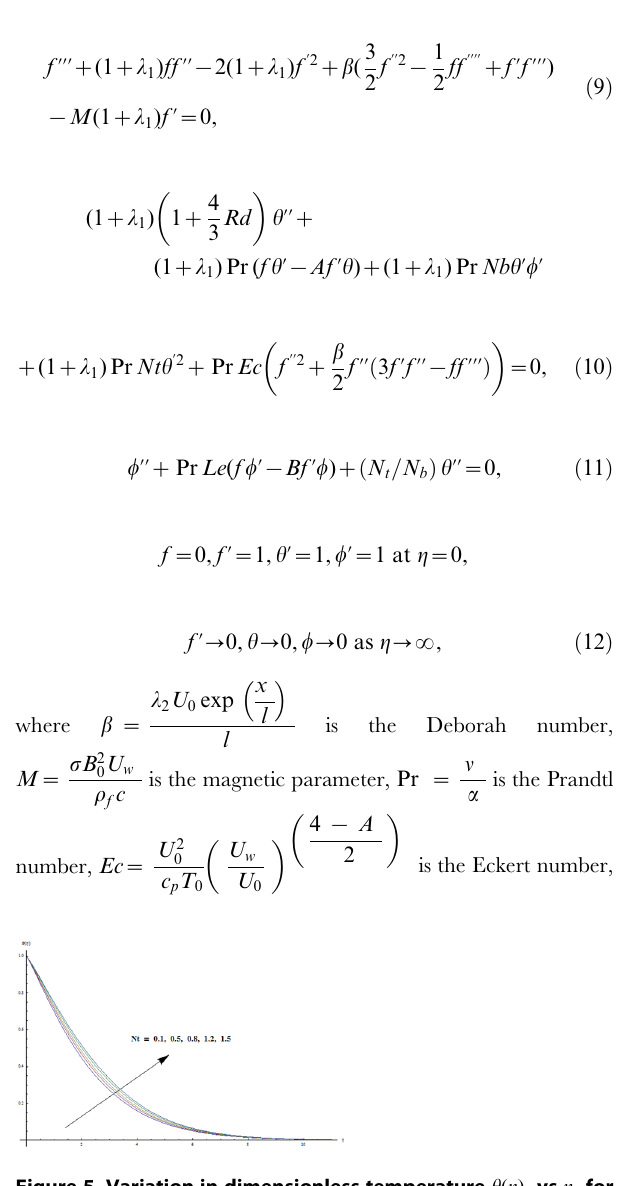
Figure 5. Variation in dimensionless temperature h ( g ) vs g for different values of Nt when l 1 ~ 0 : 3, b ~ 0 : 2, M ~ 0 : 5, Pr ~ 0 :